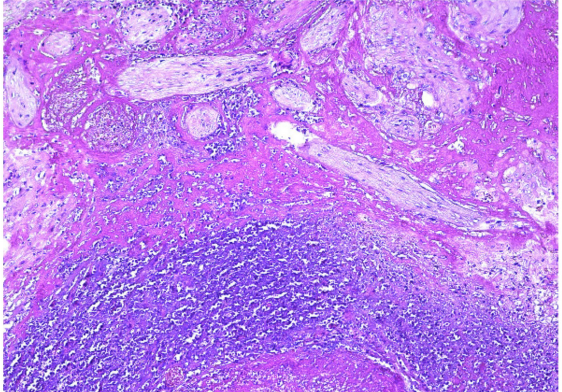
Figure 6. Fibrotic chorionic villi infiltrating myometrium (HE × 10).